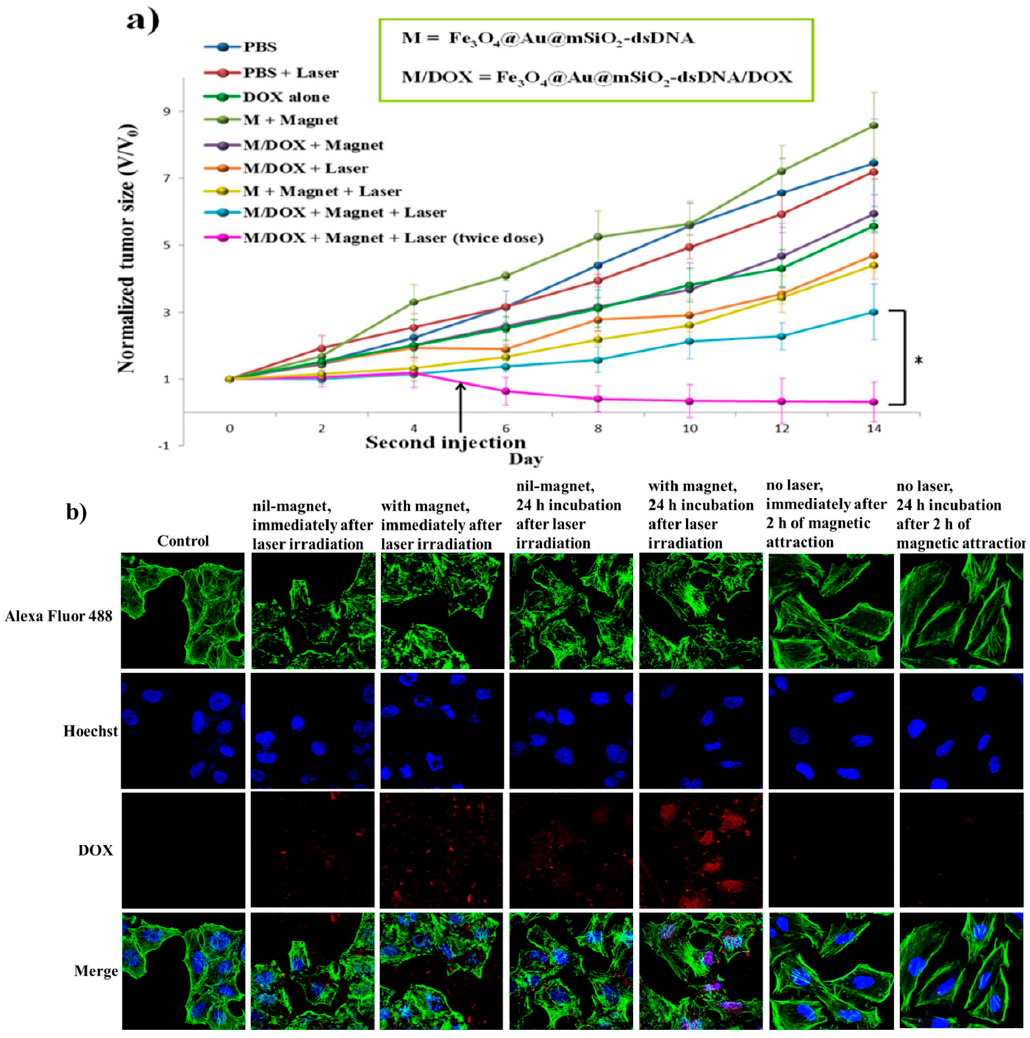
Figure 8. ( a ) A plot illustrating the changes in tumour size in mice following a number of different treatments. The tumours were seen to shrink following treatment with the drug-carrying magnetic plasmonic nanoparticles; ( b ) Also shown are confocal microscopy images of cells treated with different compounds after a range of incubation times and conditions. Reprinted with permission from [45]. Copyright ACS, 2014.